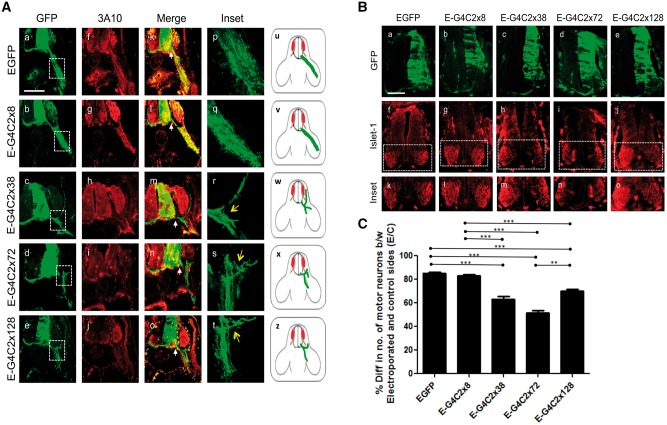
Hexanucleotide repeats affect motor neuron survival and motor axon pathways. (A) Transverse sections of E4.5 chick embryos, including spinal cord and periphery, immunostained for anti-GFP (a–e) and anti-neurofilament (f–j) to show electroporated motor axons on a background of normal nerve projections. (k–o) merged image between EGFP and 3A10 (neurofilament, red). Inset of boxed areas of the corresponding panels is magnified ten times in (p–t). Arrow indicates truncation and fasciculation of the axons (r–t). (u–z) Diagrammatic representation of perturbations of axon pathways (red; motor neuron, green; motor neuron outgrowth). (B) Embryos were electroporated with EGFP-G4C2x8, x38, x72, x128 at E3.5, then transverse sections of embryonic day E4.5 chick embryo spinal cords were immunostained (a–e) with GFP and anti-Islet-1 antibodies, which detect motor neurons (f–j). (C) The semi-quantitative analysis shows the percentage difference between the number of motor neuron on the control side and the number of motor neuron on the electroporated side. Scale bar=100 μm. The data were analysed from six embryos in three independent sets of experiments.